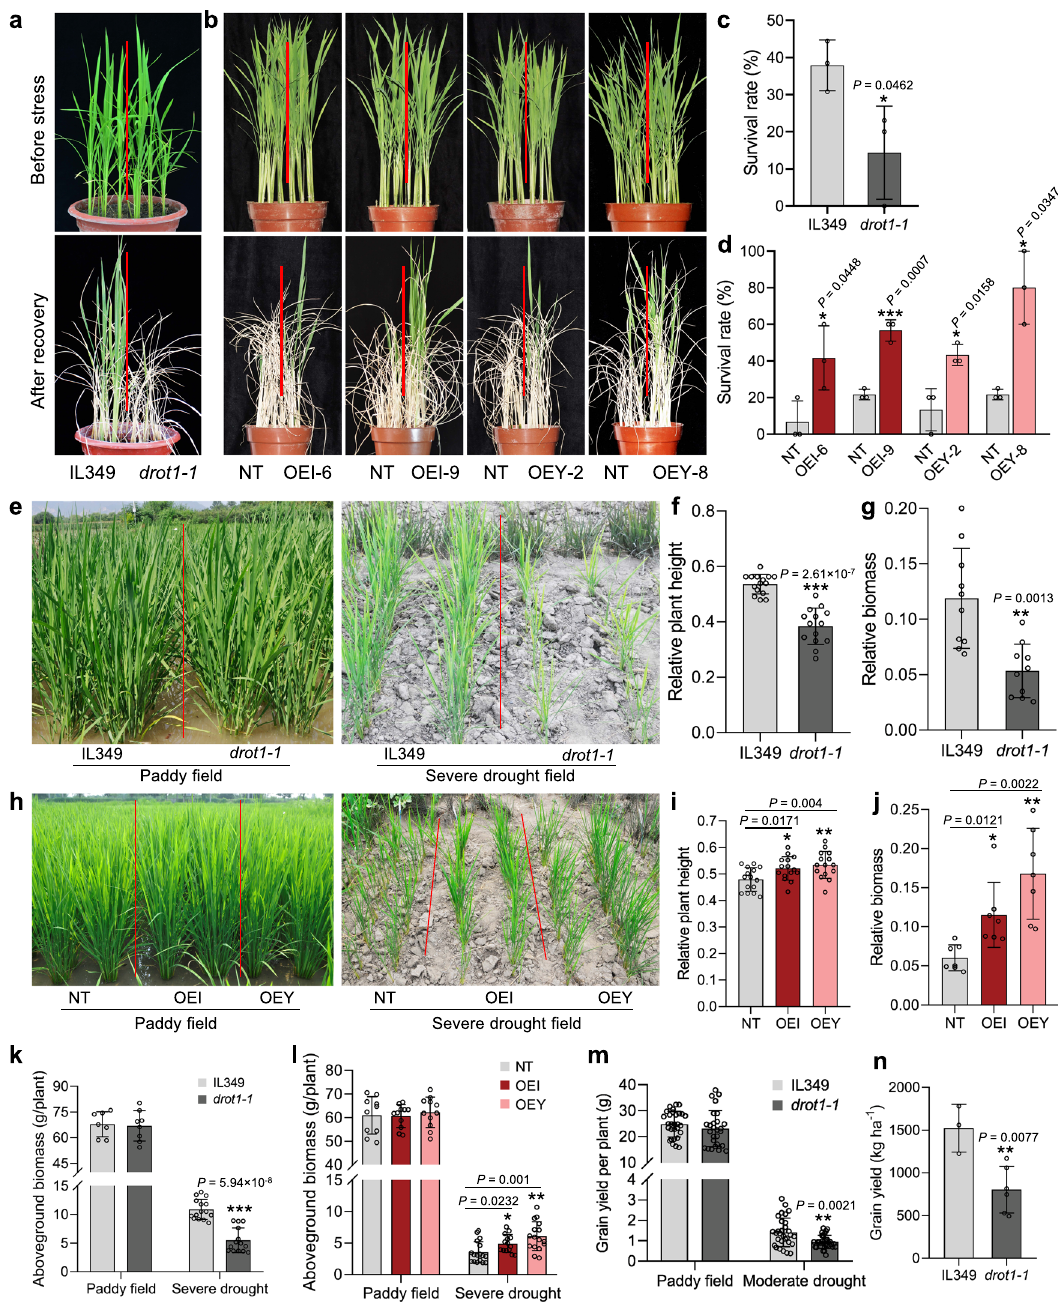
Fig. 2 Functional validation of DROT1 in drought resistance. a Drought resistance of drot1-1 compared to IL349. b Drought resistance of DROT1 - overexpressing transgenic lines compared to NT (negative transgenic control). The seedlings grown for 4 weeks under normal conditions (top in a , b ) were treated by drought stress for 15 days, followed by re-watering for 10 days (bottom in a , b ). c Survival rates of IL349 and drot1-1 seedlings after re-watering. Data represent means ± s.d. ( n = 3 biological replicates). d Survival rates of NT, OEI and OEY seedlings after re-watering. Data represent means ± s.d. ( n = 3 biological replicates). e Growth performance of drot1-1 and IL349 grown in paddy fi eld and severe drought fi eld for 90 days. f Relative plant height of drot1-1 and IL349. Data represent means ± s.d. ( n = 15/14 plants). g Relative aboveground biomass of drot1-1 and IL349. Data represent means ± s.d. ( n = 10 plants). h Growth performance of NT and OE lines grown in paddy fi eld and drought fi eld for 90 days. i Relative plant height of NT, OEI and OEY. Data represent means± s.d. ( n = 15 plants). The values of relative plant height ( f , i ) were calculated by plant height in severe drought fi eld divided by those in paddy fi eld. j Relative aboveground biomass of NT, OEI and OEY. Data represent means ± s.d. ( n = 7 plants). The values of relative biomass ( g , j ) were calculated by plant biomass in severe drought fi eld divided by those in paddy fi eld. k Aboveground biomass of drot1-1 and IL349 at mature stage. Data represent means ± s.d. ( n = 7/8, 15/14 plants). l Aboveground biomass of NT, OEI and OEY at mature stage. Data represent means ± s.d. ( n = 10/11/11, 17/ 14/16 plants). m Grain yield per plant of drot1-1 and IL349 under paddy fi eld and moderate drought fi eld. Data represent means ± s.d. ( n = 29/27, 30/30 plants). n Grain yield per hectare of drot1-1 and IL349 under moderate drought fi eld. Data represent means ± s.d. ( n = 3/6 plots). Asterisks indicate statistical signi fi cance by two-tailed Student ’ s t- tests (* P < 0.05, ** P < 0.01, *** P < 0.001). Source data are provided as a Source Data fi le.